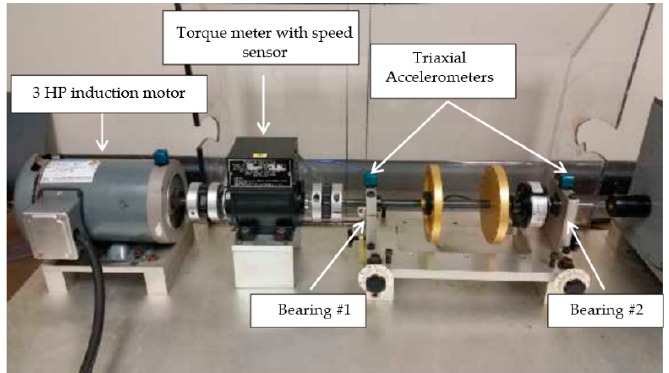
Figure 21. Waveforms of ultrasonic signals on different operation conditions (Adapted from [184]).